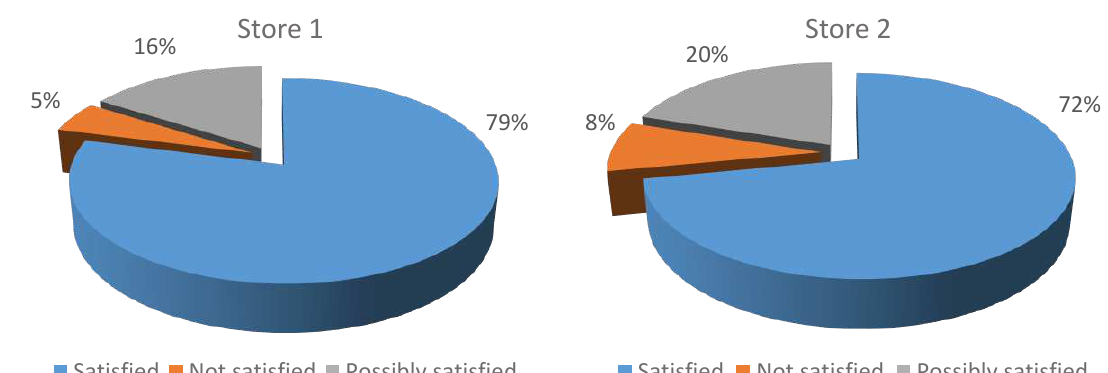
Figure 3. The level of customer satisfaction with the variety of